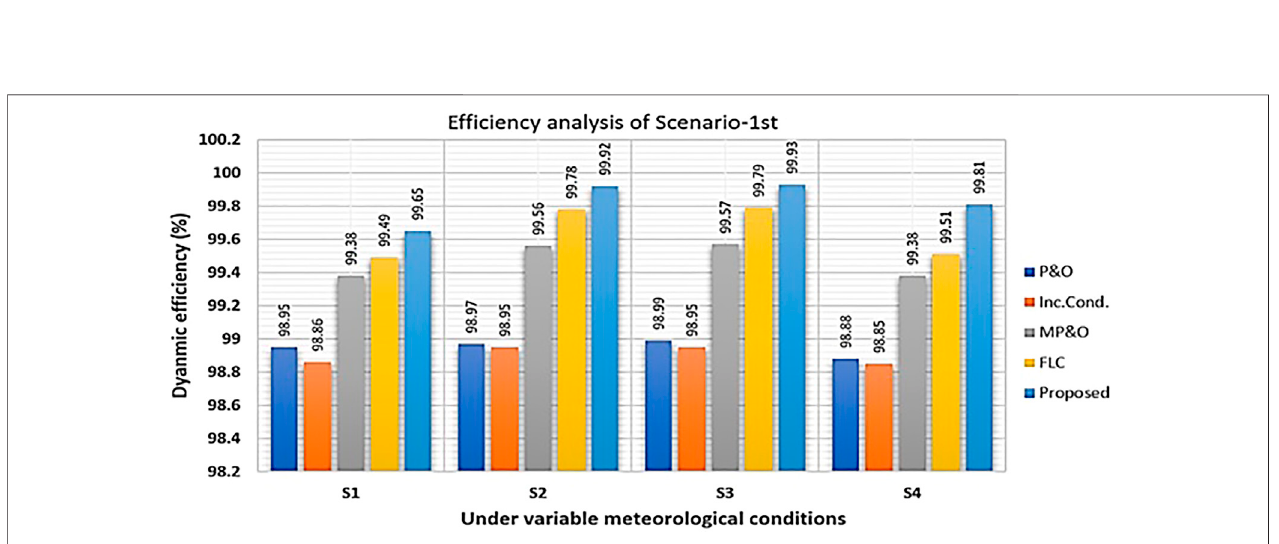
FIGURE 14 | Convergence time and dynamic ef fi ciency under scenario- fi